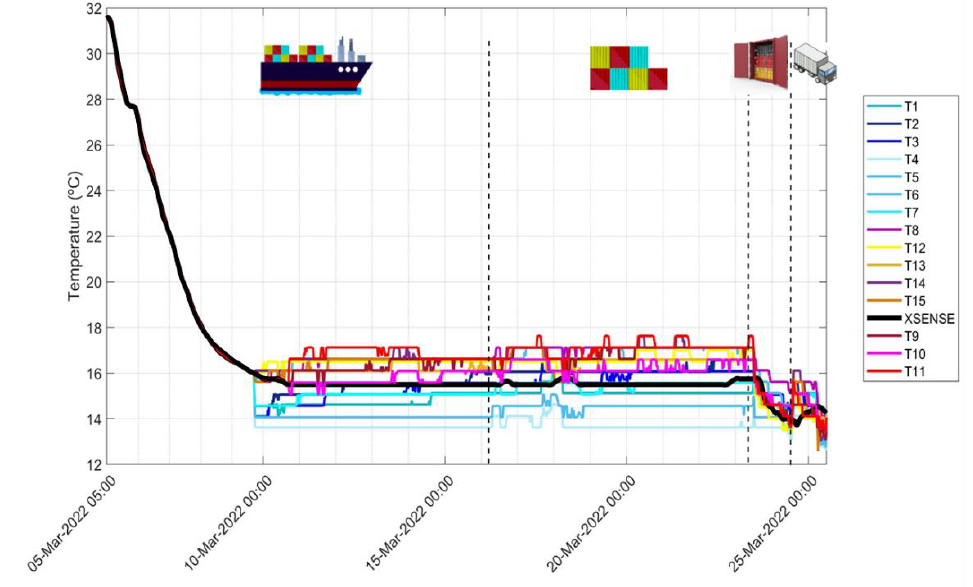
Figure 2. Time series of temperatures recorded by the Xsense logger and the 15 ibuttons, inside the reefer, throughout the whole transport itinerary.